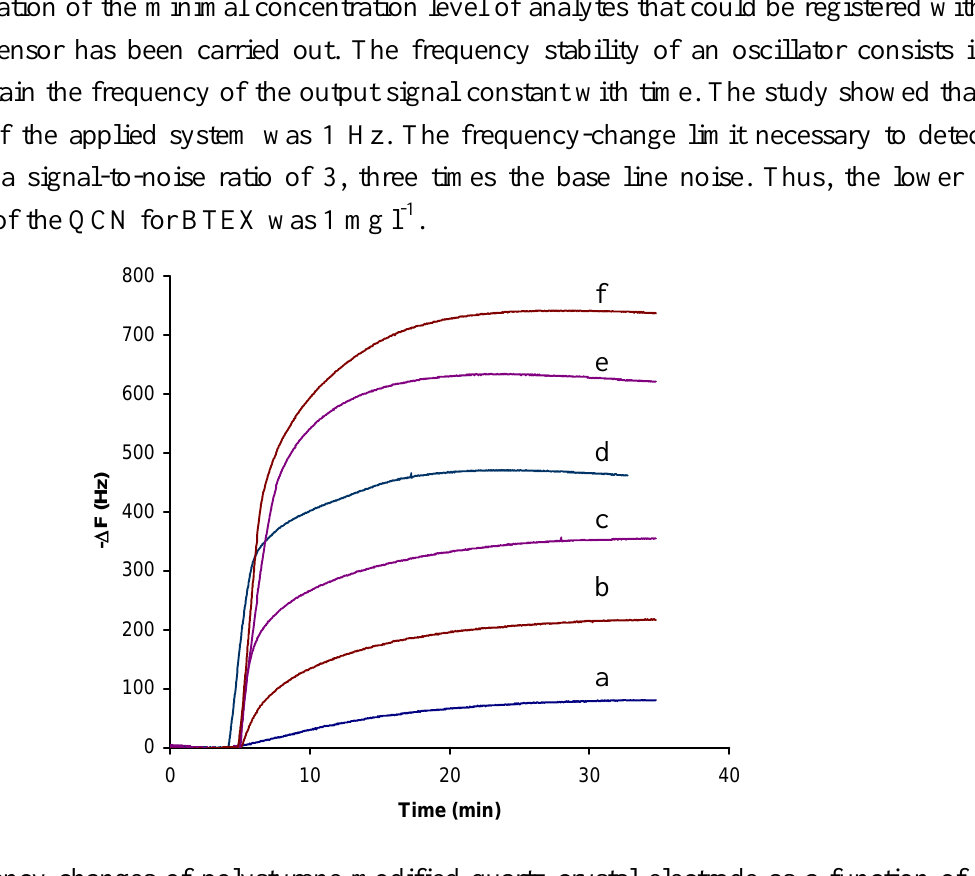
Figure 5. Frequency changes of polystyrene-modified quartz crystal electrode as a function of time exposed to various concentrations of toluene: (a) 0.91 mg l − 1 , (b) 9.07 mg l − 1 , (c) 18.14 mg l − 1 , (d) 27.21 mg l − 1 , (e) 36.28 mg l − 1 , (f) 45.35 mg l − 1 . Polymer cast from a 0.5% (w/v) of polystyrene / chloroform